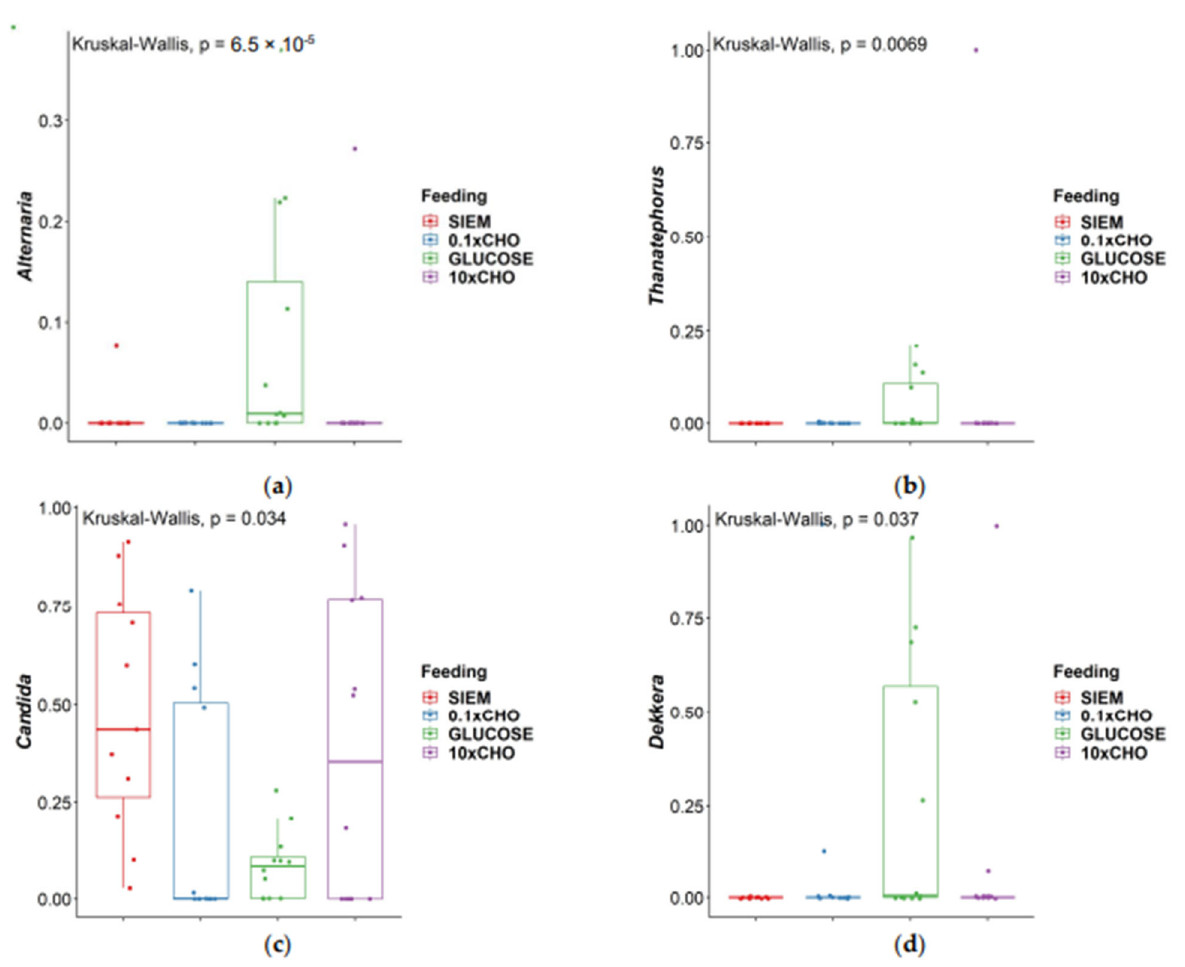
Figure 8. Box ‐ plot of genera: ( a ) Alternaria ; ( b ) Thanatephorus ; ( c ) Candida ; ( d ) Dekkera that were significantly different (Kruskal – Wallis test) for different dietary interventions ( p < 0.05). Dunn’s post hoc test was carried out to indicate the groups that were significantly different. Table 5. Genera that are significantly different over time during the intervention period. Comparison Alternaria Thanatephorus Candida Dekkera